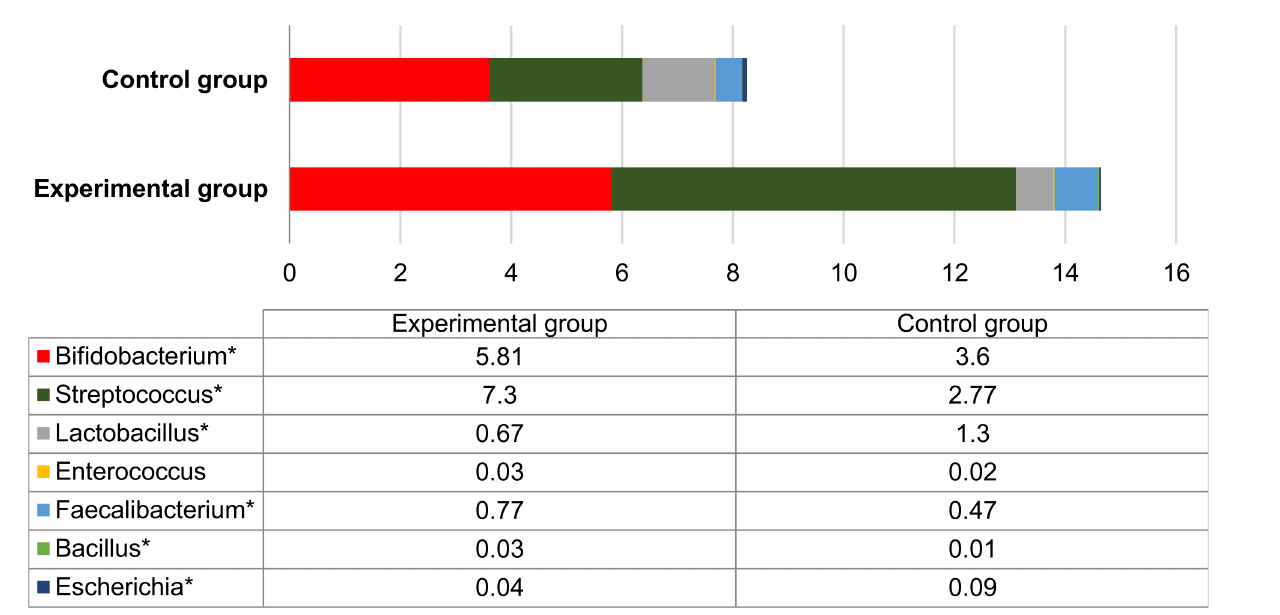
Figure 6. The percentage of probiotic bacteria in negative control and test animal groups at the end of experiment (28 DPI). Asterisk indicates statistical significance between groups (* p <